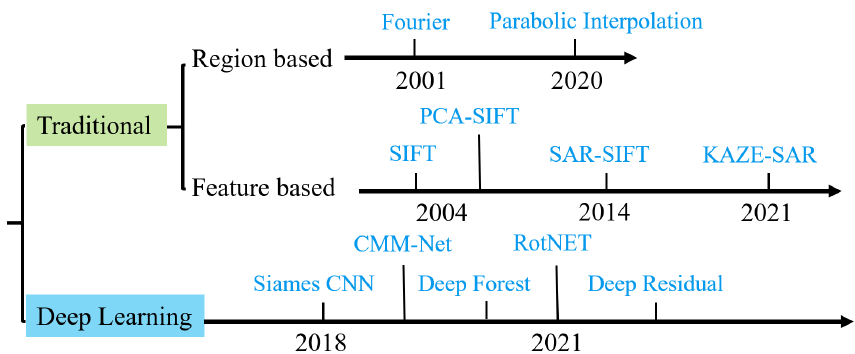
Figure 1. Remote sensing image registration milestones in the last two decades. 103